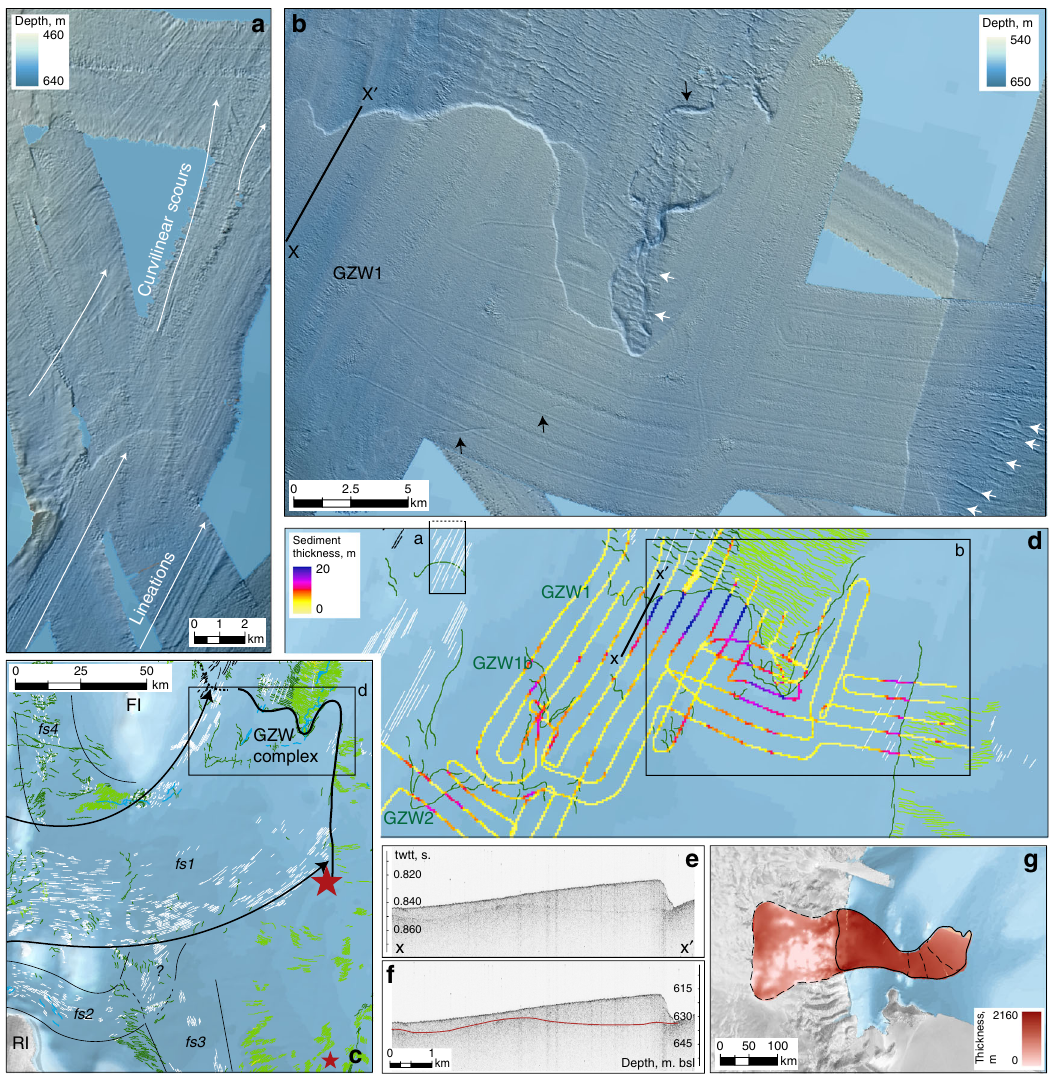
Fig. 4 Readvance assemblage in southern JOIDES Trough. Background bathymetry from IBCSO 76 ; acoustic data compiled and visualised as described in the 'Methods'. a Lineations crossing a grounding zone wedge front transition to curvilinear iceberg/keel scours distally. b Large, composite GZW (1) overprints an earlier retreat sequence comprising W-E recessional moraines (arrowed in white). A meltwater channel system both under- and overlies GZW1 (arrowed in black). c Lineation assemblage (in white) indicates fl ow from Southern Victoria Land to the JOIDES GZW complex ( fl owset fs1 ), possibly joined by fs2 and apparently truncating fs3 , indicating unzipping of fl ow in Central Basin prior and/or subsequent to readvance. Large red star marks the southern limit of where landforms associated with the readvance superimpose earlier retreat moraines, i.e. the minimum distance of initial retreat, prior to readvance; smaller star marks southern continuation of the moraine fi eld. FI = Franklin Island, RI = Ross Island. d Sediment thickness within the GZW complex (GZWs 1, 1b & 2), based on a buried horizon ( e , f ) mapped from the NBP1502A subbottom acoustic survey. g Potential catchment of the readvance event, assuming a range of durations and fl ow velocities (see SVL sector of the EAIS, but contributed a potentially signi fi cant rise therefore developed, at least semi-independent of the main volume of ice to the ocean. EAIS.